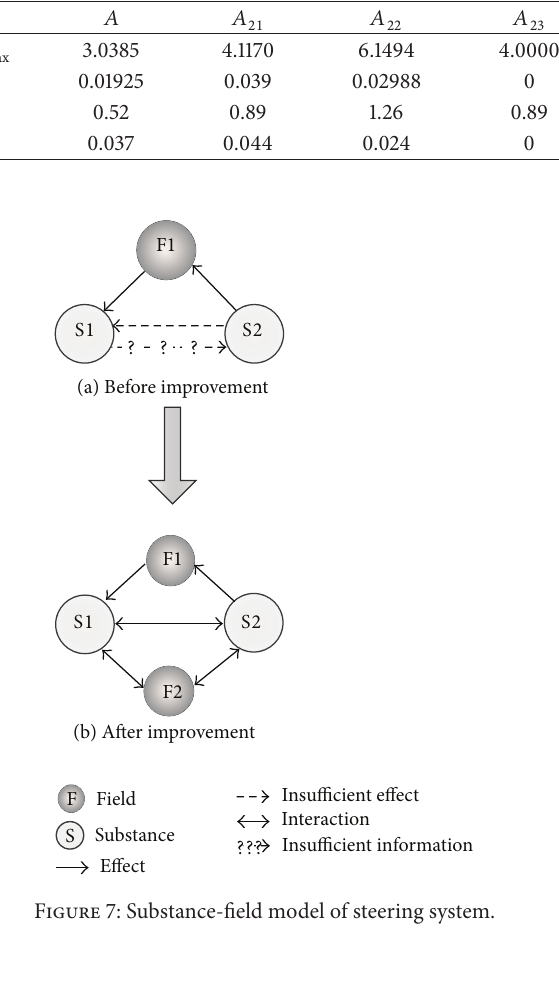
Table 3: Results of the consistency check.